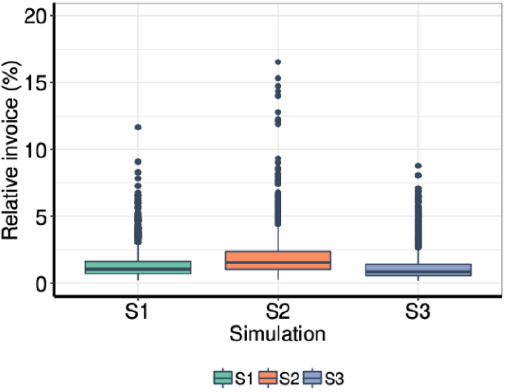
Figure 10. Simulated invoice relative to the household income for the three scenarios.